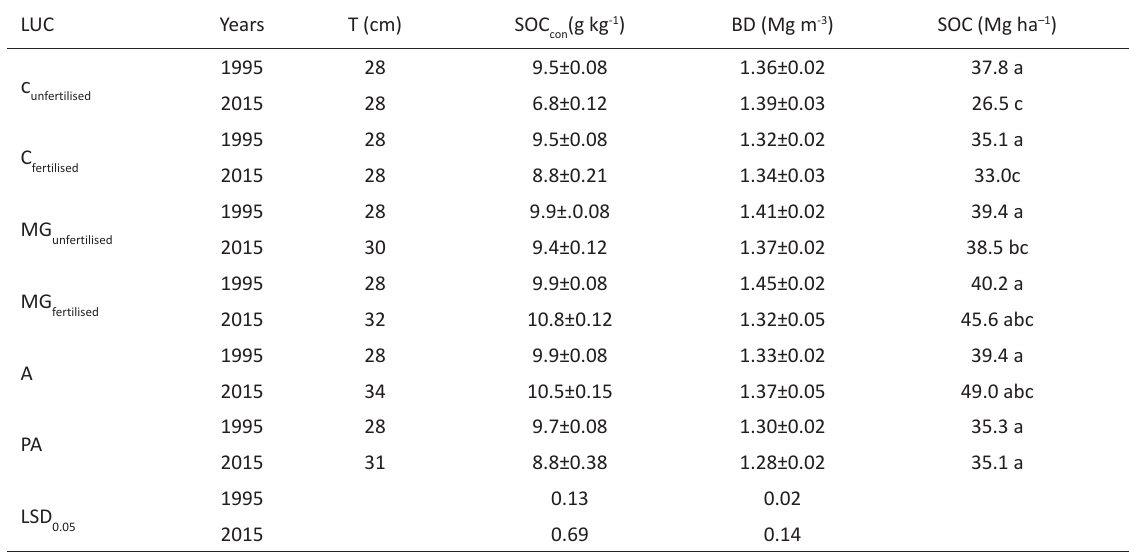
Table 2. Organic carbon accumulation in soil LUC